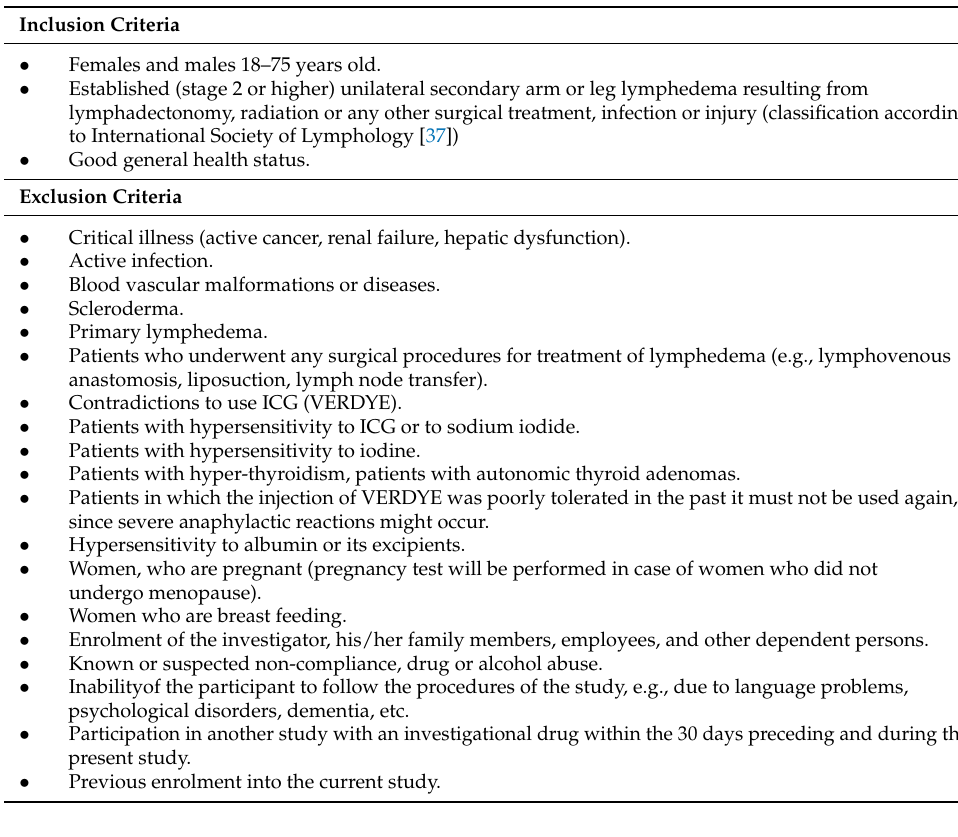
Table 1. Inclusion and exclusion criteria.